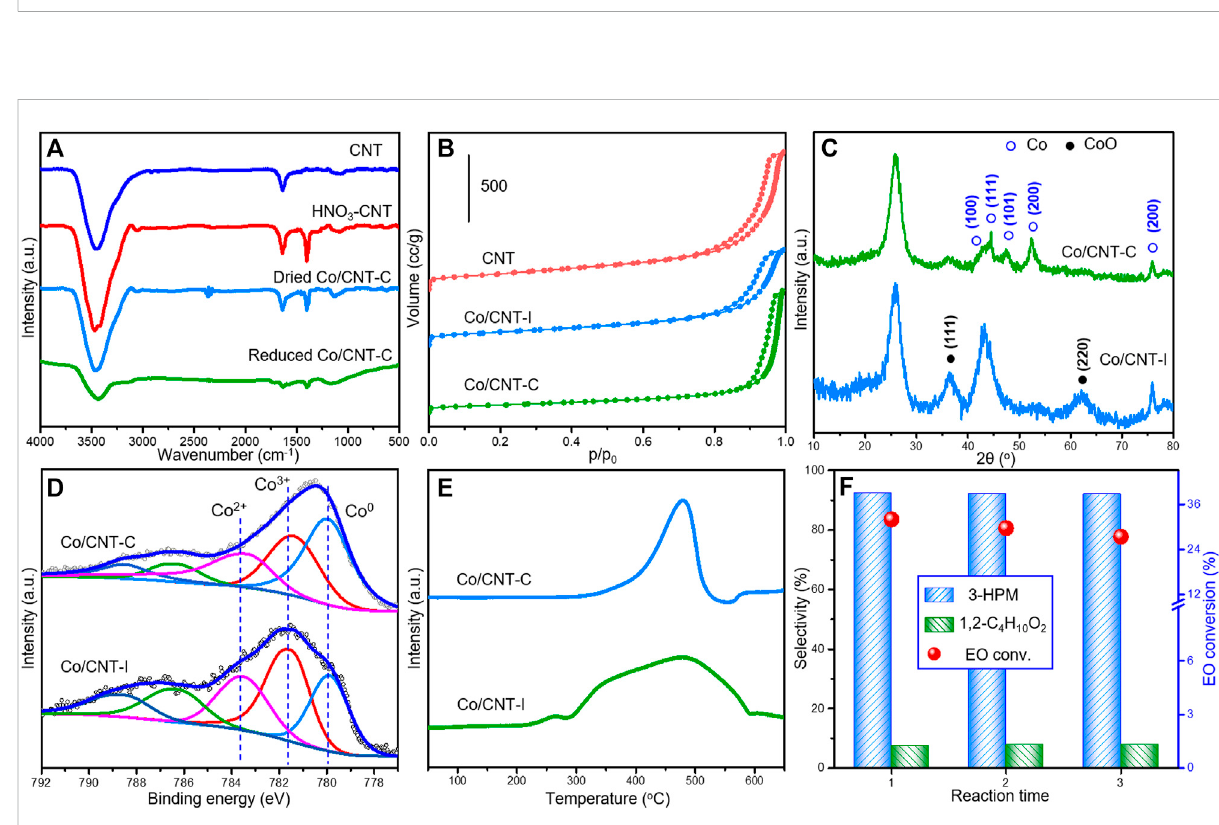
FIGURE 5 (A) FT-IR spectra of Co/CNT-C during the synthesis process, (B) N core level, (E) H 2 -TPRpro fi les ofCo/CNT-Cand Co/CNT-Iby differentmethods,and (F) Cycle tests by Co/CNT-C. Reaction condition:60 ° C,5 MPa CO for 5 h; Co/EO = 0.3/15 (0.1 g catalyst), balanced with